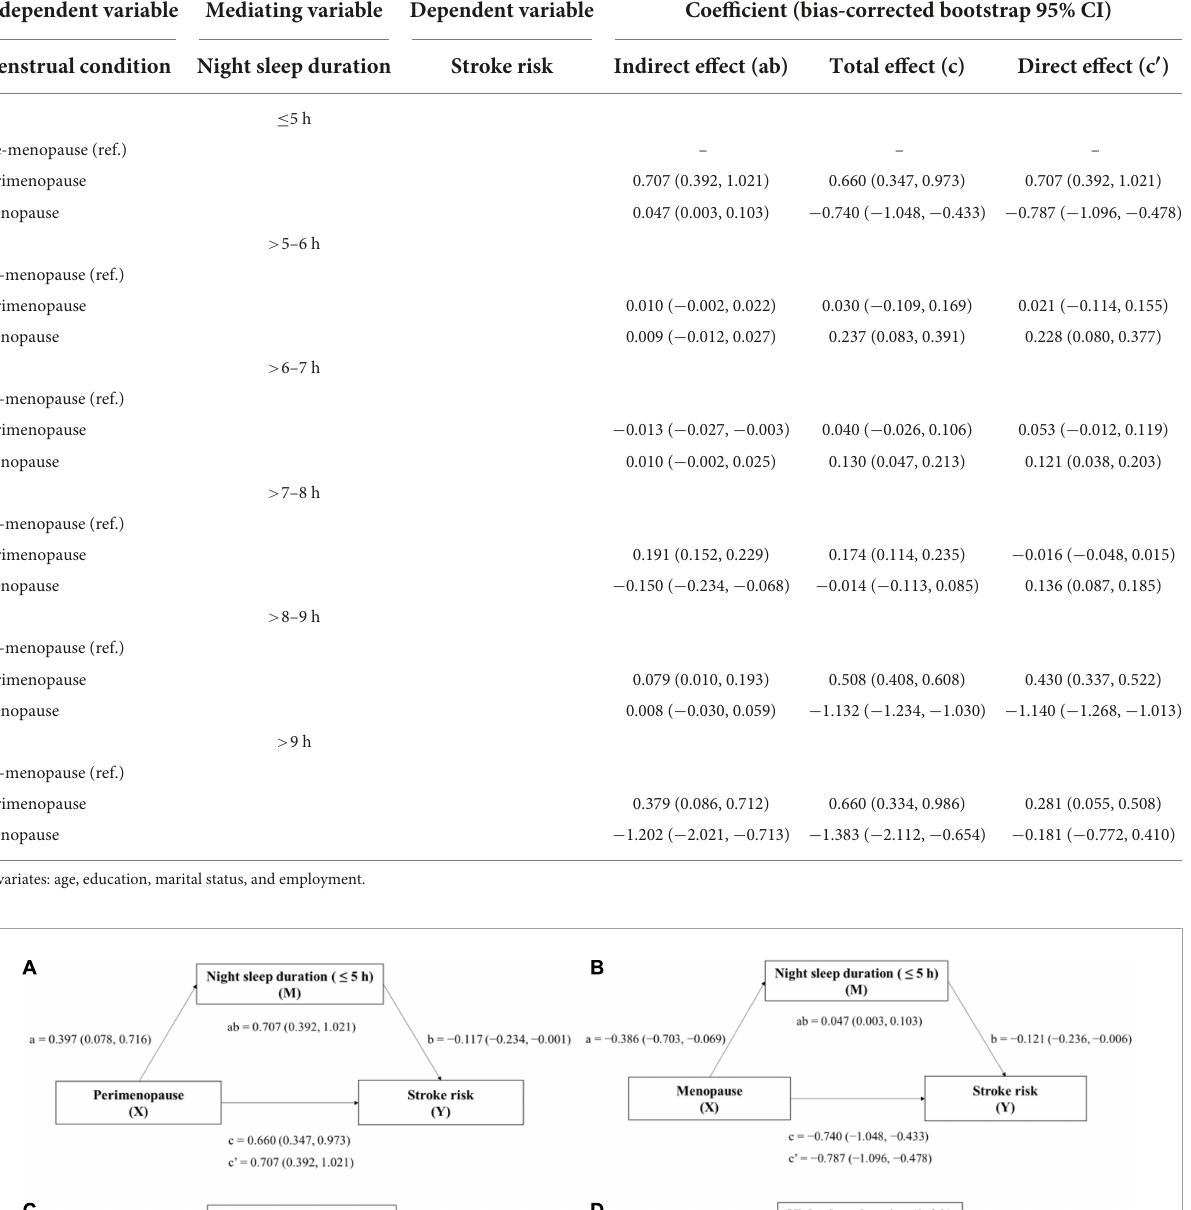
TABLE 5 Mediating effect of night sleep duration on the relationship between menopausal status and stroke risk.